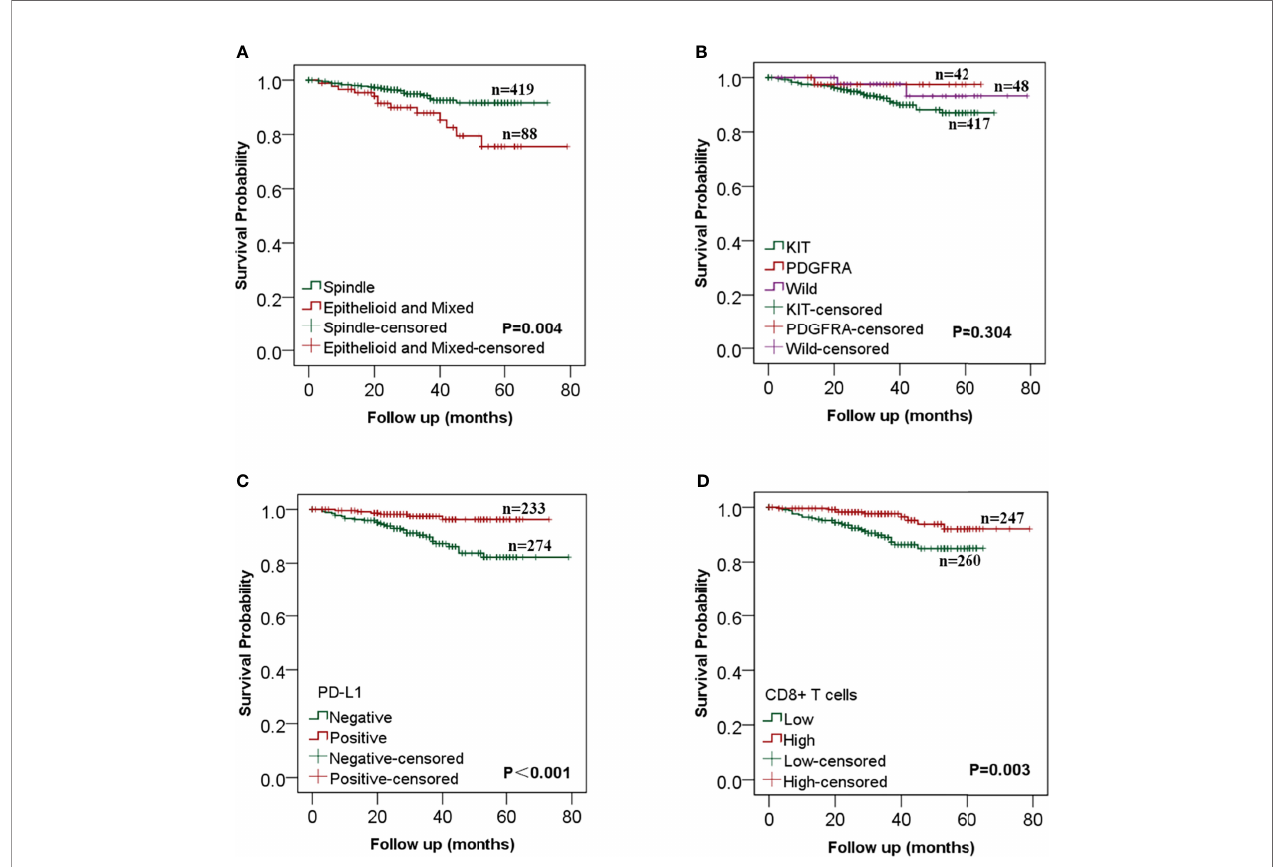
FIGURE 3 | Kaplan – Meier analysis of the relationships between clinicopathological features and recurrence-free survival in gastrointestinal stromal tumors (GISTs). (A) GIST patients with the spindle cell type had a better RFS than those with epithelial and mixed cell; (B) There was no statistical difference in RFS between different mutation types; (C) RFS was signi fi cantly longer in patients with high PD-L1 expression than that in patients with low PD-L1 expression; (D) The increase of CD8+ T cells was signi fi cantly correlated with better